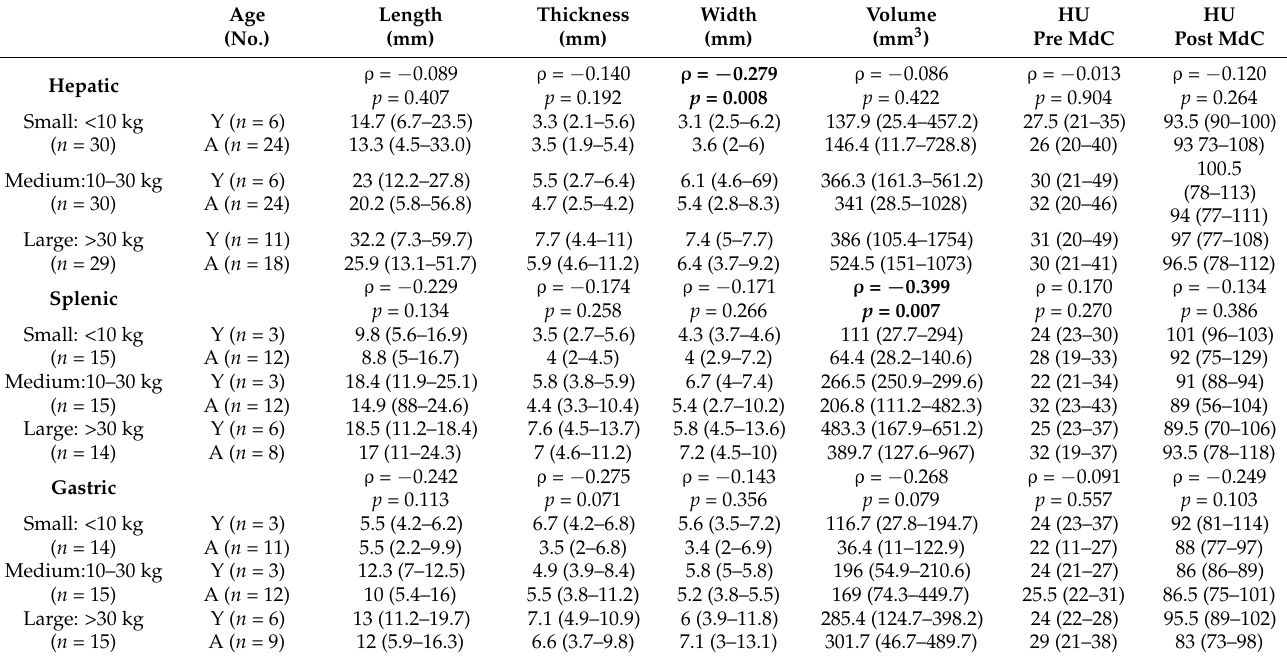
Table 5. Median and range (within parentheses) values of ALs size and attenuation according to age and body weight categories. Data are stratified by